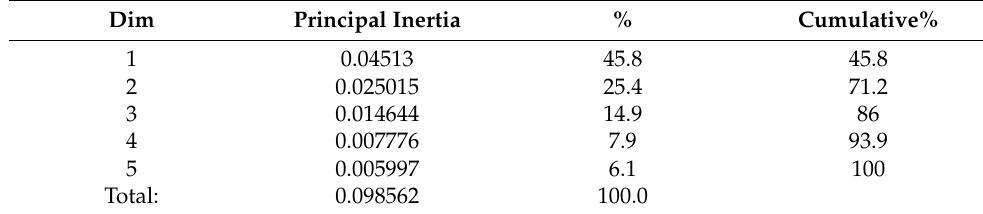
Table 1. Result summary for the inertia.